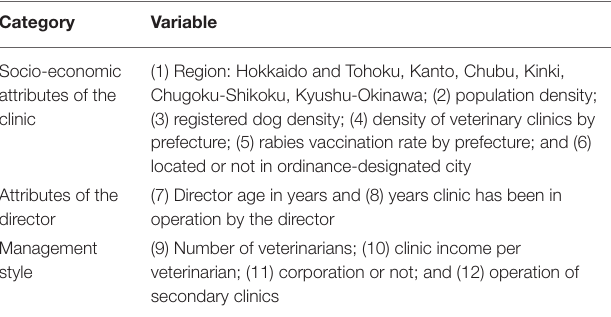
TABLE 1 | Variables examined for the statistical analysis of the relationship with antimicrobial drug